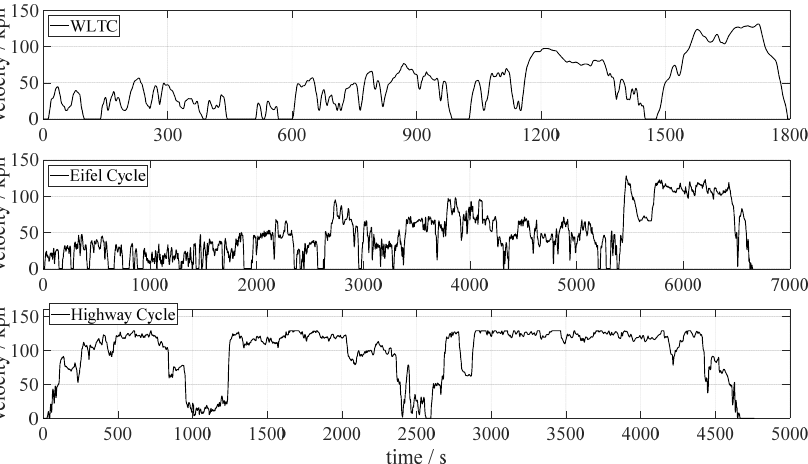
Figure 7. Driving cycles considered in this contribution: WLTC, Eifel Cycle (with rural and highway parts), and Highway Cycle from Aachen to